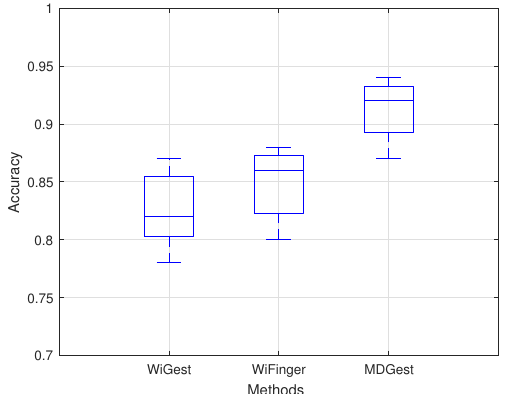
Figure 7. Accuracy of different methods.